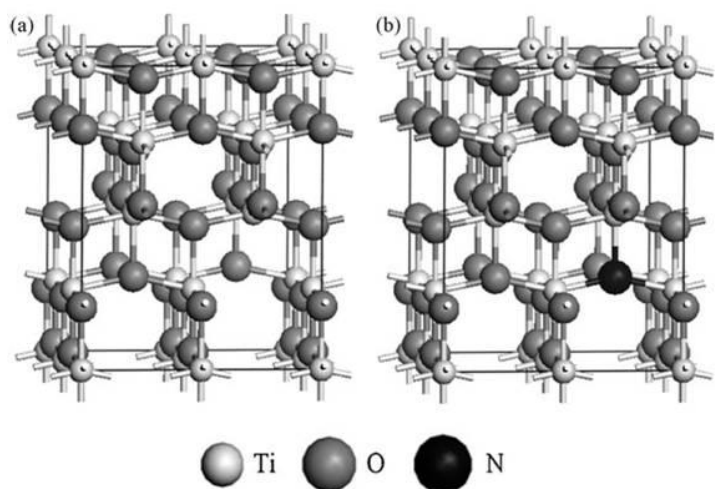
Figure 3. Schematic models in a 2 × 2 × 1 supercell for ( a ) oxygen vacancy and ( b ) substitutional N-doping. Reprinted with permission from [21], copyright 2009, Elsevier.